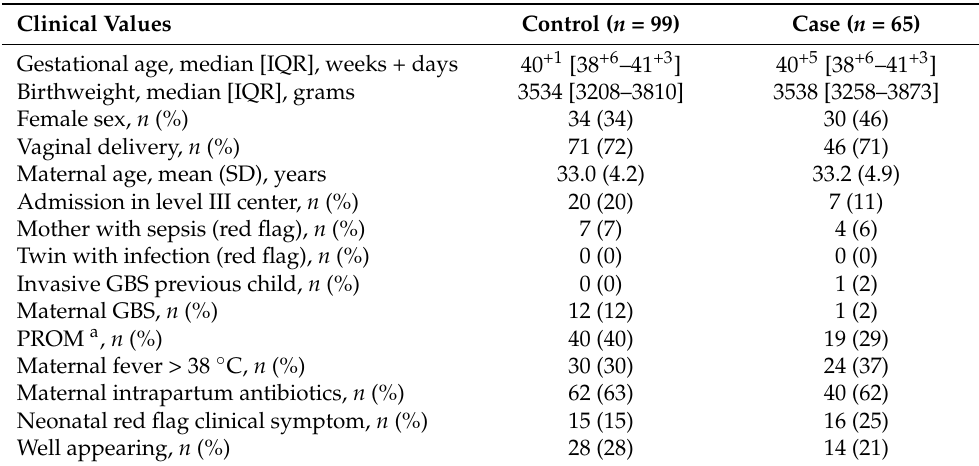
Table 1. Baseline characteristics of term-born